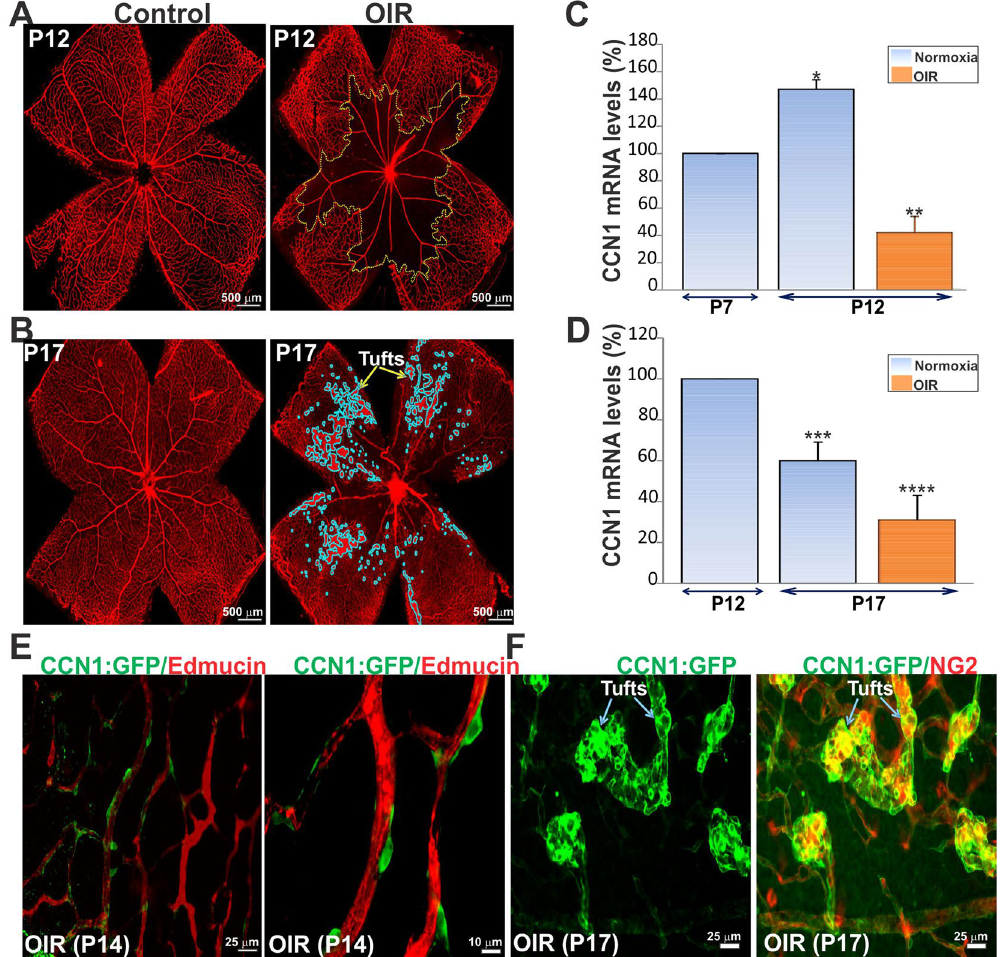
Figure 2. OIR-induced pre-retinal neovasculatization is associated with the expression of CCN1 in pericytes. ( A , B ) Representative flat mount preparations of IB4-stained retinas from control and OIR mice. Mouse pups were placed at P7 under hyperoxia (75% oxygen) or ambient air (normoxia) for 5 days. Mice were returned to ambient air until P17. Areas of vaso-obliteration and preretinal neovascular tufts as determined by computer- assisted image analyses are shown with dotted yellow lines and blue outline respectively. ( C , D ) Steady state mRNA levels of CCN1 following the hyperoxic (P7 to P12) and ischemic (P12 to P17) phases of OIR as determined by qPCR. CCN1 mRNA levels were normalized to those of 18S rRNA. ( n = 4). * p < 0.05 versus P7 (normoxia); ** p < 0.001 versus P12 (normoxia); *** p < 0.05 versus P12 (normoxia); **** p < 0.05 versus P17 (normoxia). ( E , F ) Flat mounted preparations of retinas of the CCN1:GFP reporter mice subjected to OIR. Retinas were collected during the posthyperoxic phase at either P14 or P17 and stained with the endothelial marker endomucin (Edmucin) or the pericyte marker NG2. Note that CCN1:GFP-positive cells are endomucin- negative and that the CCN1:GFP signal localized predominantly in NG2-positive cells of neovascular